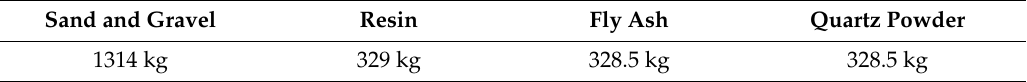
Table 3. Mixing proportions by weight (kg) for a concrete volume of 1 m 3 . Sand and